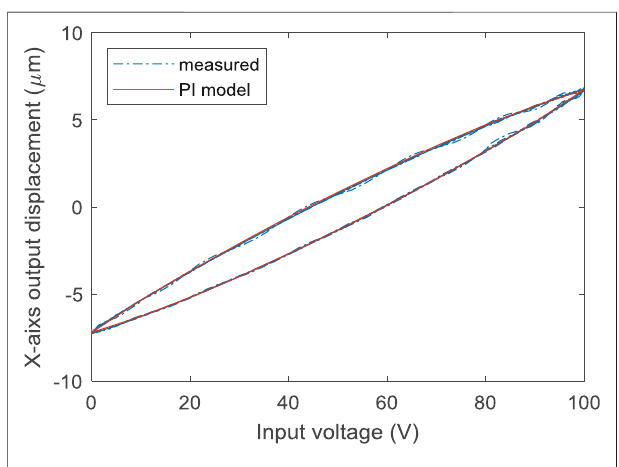
FIGURE 4 | Modeling result of the P-I